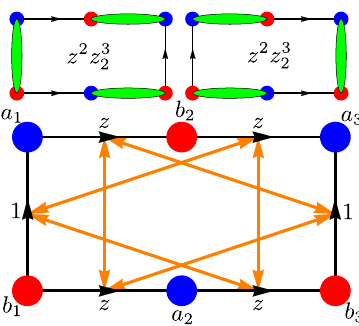
Figure 37: Dimer covering and Grassmann path integral representation of the partition function for the hexagonal plaquette. The interacting dimer model, Z hon2 [ Eq. 72 ] , has dimer weight 1 on A bonds and z on B and C bonds, and there is a weight z associated with interactions between dimers 2 separated by a single unfilled bond. (Top) The two dimer coverings of the hexagonal plaquette are shown, along with the associated weights. (Bottom) The partition function can be recast as a path integral over Grassmann variables associated with vertices of the plaquette (red and blue disks). The action consists of 2, 4 and 6 body interactions, and the allowed 4-body interactions are represented as orange arrows connecting pairs of